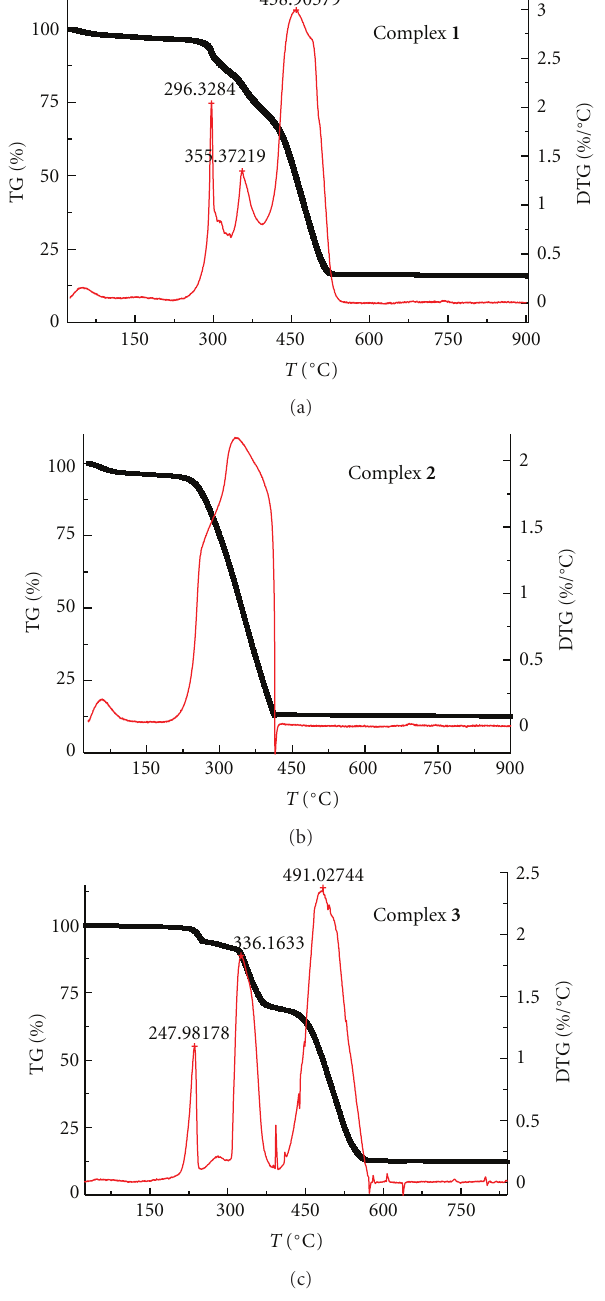
Figure 1: TG-DTG curves of the Cu(II) complexes.